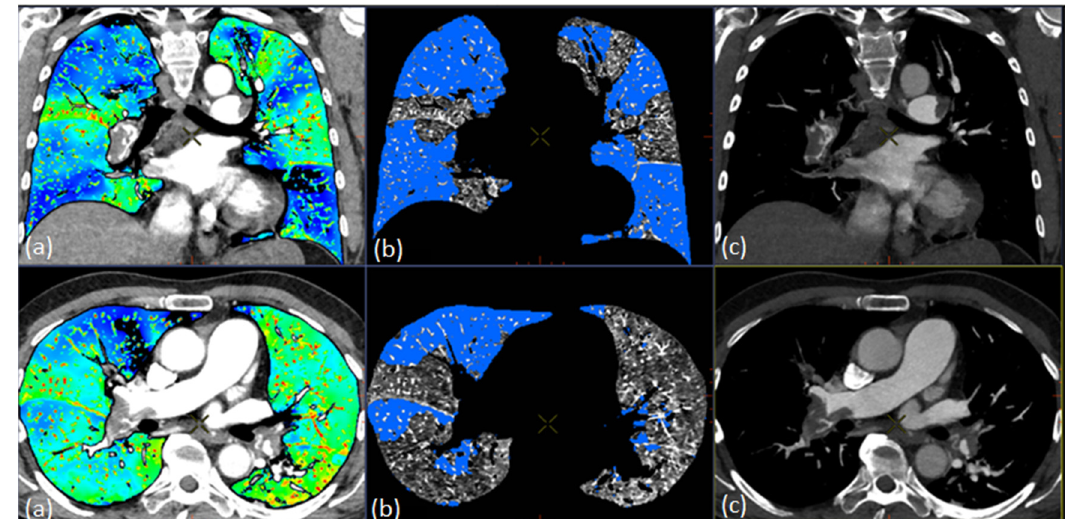
Figure 4. Dual-energy CT, Thoracic VCAR application, gemstone spectral imaging (GSI) pulmonary perfusion in a patient with acute pulmonary embolism. ( a ) Visualization of pulmonary perfusion by colorized iodine overlay. ( b ) Automatic segmentation showing regions (blue areas) representing relative perfusion deficit. ( c ) Monochromatic input volume.